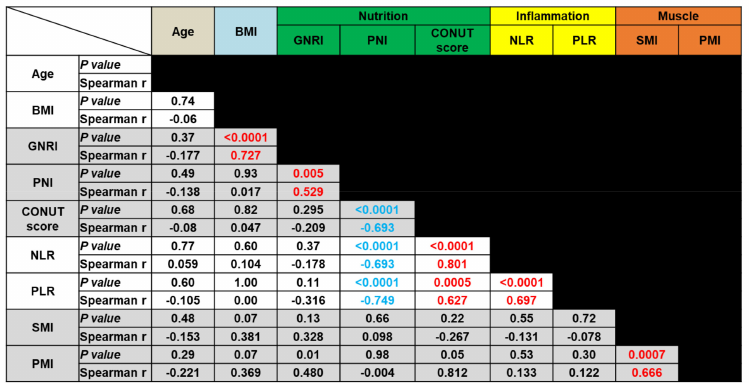
Figure 2. Correlations between nutritional status-, inflammation-, and muscle mass-based markers.